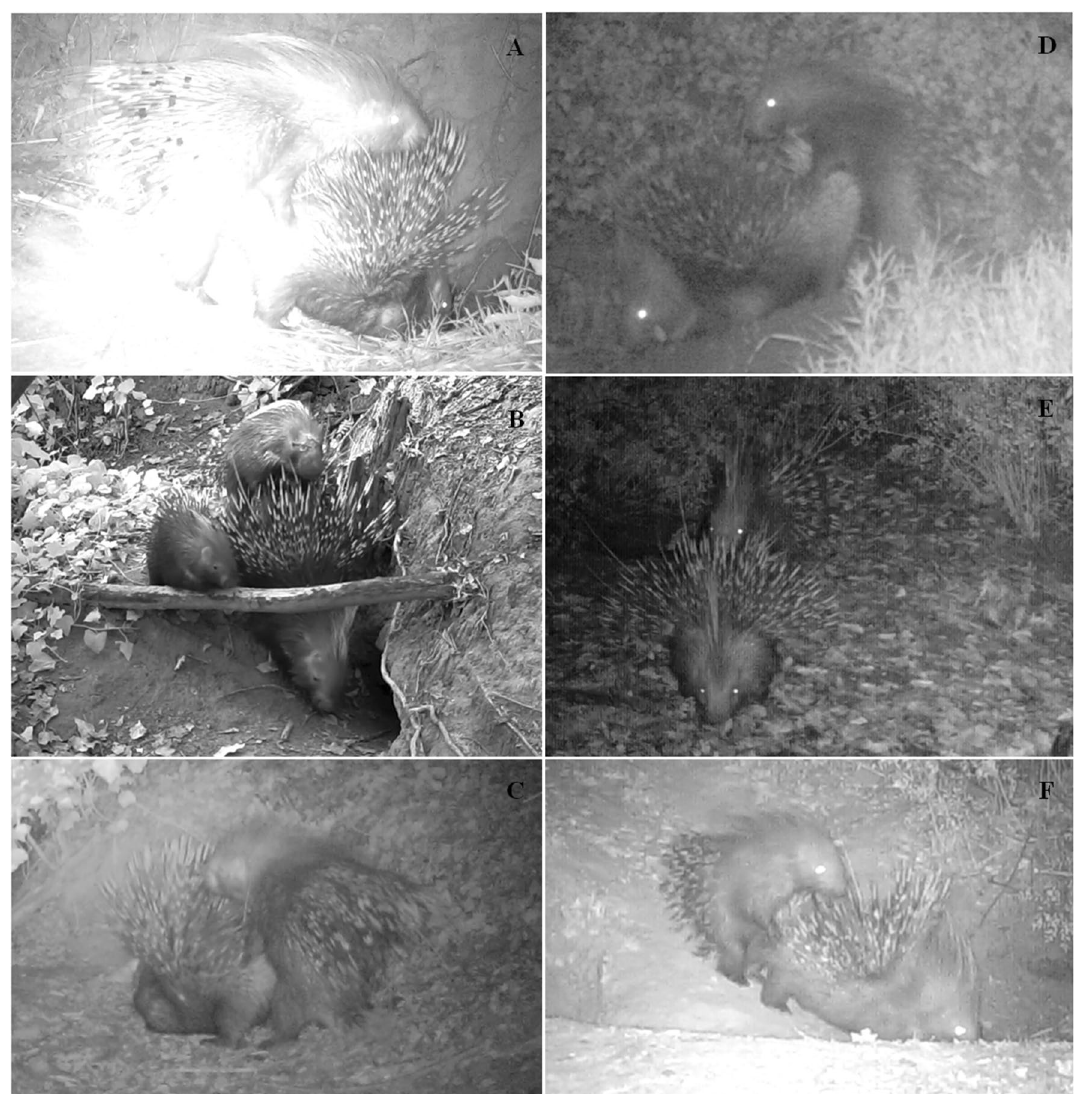
Figure 1. Mounting behaviour events recorded in Pair 2 ( A ), in Pair 5 ( B ), in Pair 1 ( C ) in Pair 4 ( D ), in Pair 7 ( E ) and in Pair 8 ( F ). Marked porcupines or porcupines with phenotypic peculiarities are visible.